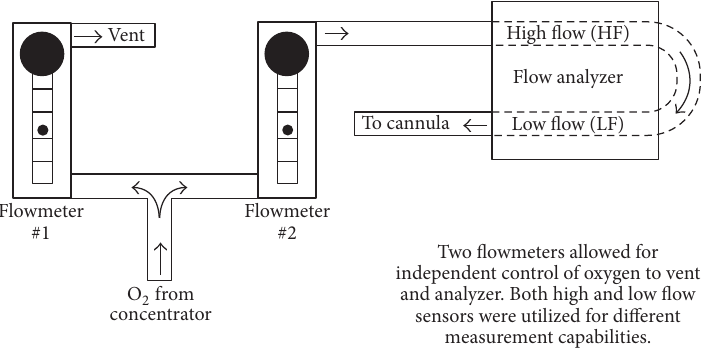
Figure 4: Setup of external flowmeters and flow analyzer.